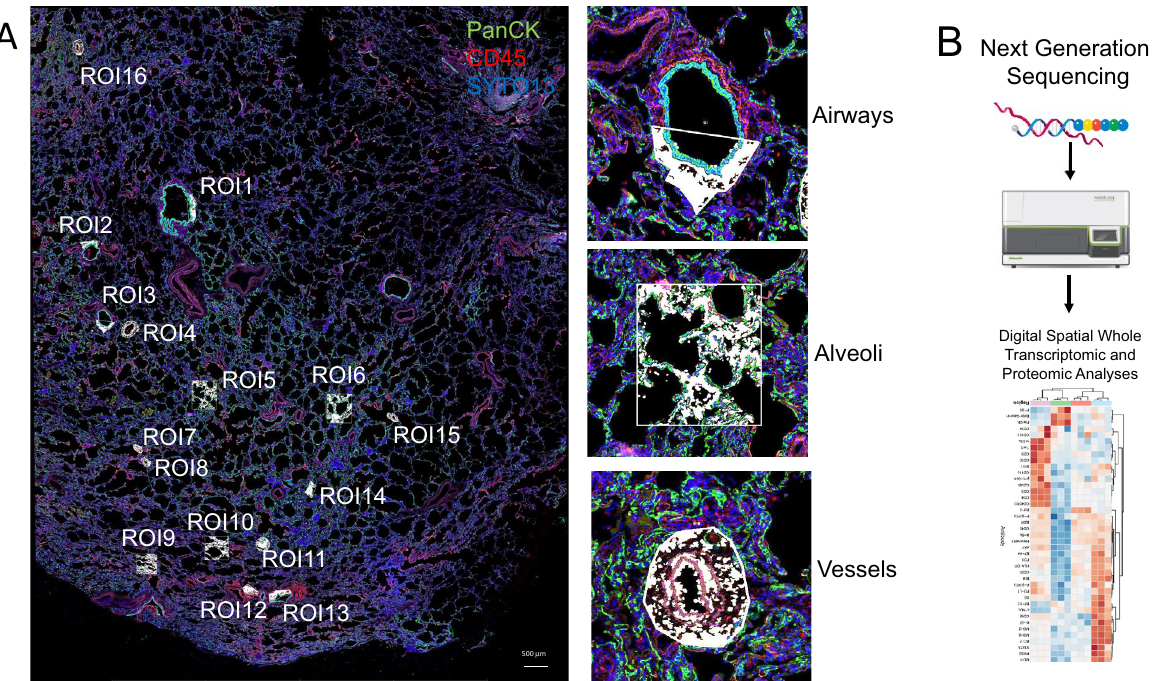
Figure 1. NanoString GeoMx spatial protein and transcriptomic profiling: ( A ) Image of a lung tissue section from a representative COPD subject stained with pan-cytokeratin (green), CD45 (red) and SYTO13 (blue). The regions of interest (ROIs) sampled for spatial protein and RNA analysis are highlighted in the white boxes. ( B ) The workflow of protein and RNA data analyses is